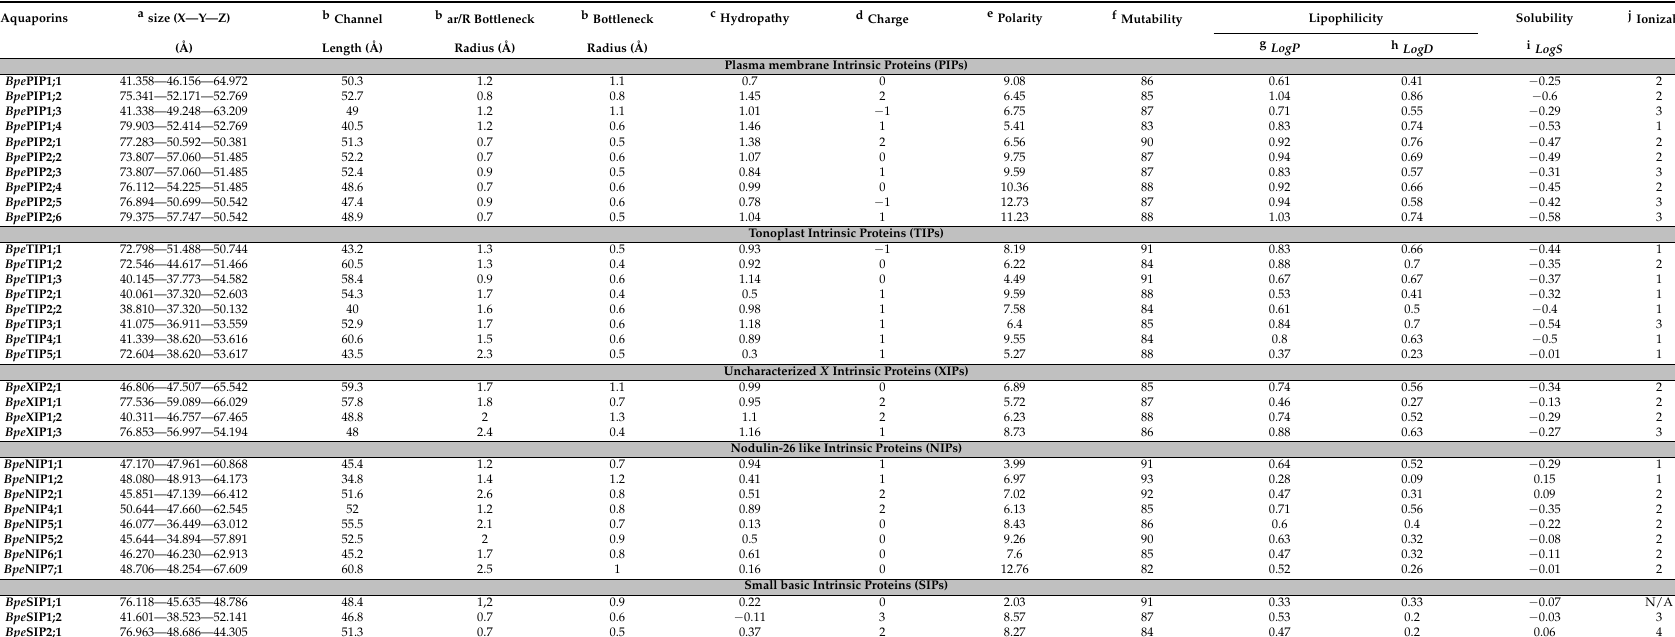
Table 2. Physicochemical properties of the pore structure predicted for the protein of Bpe AQPs from Betula pendula (complete